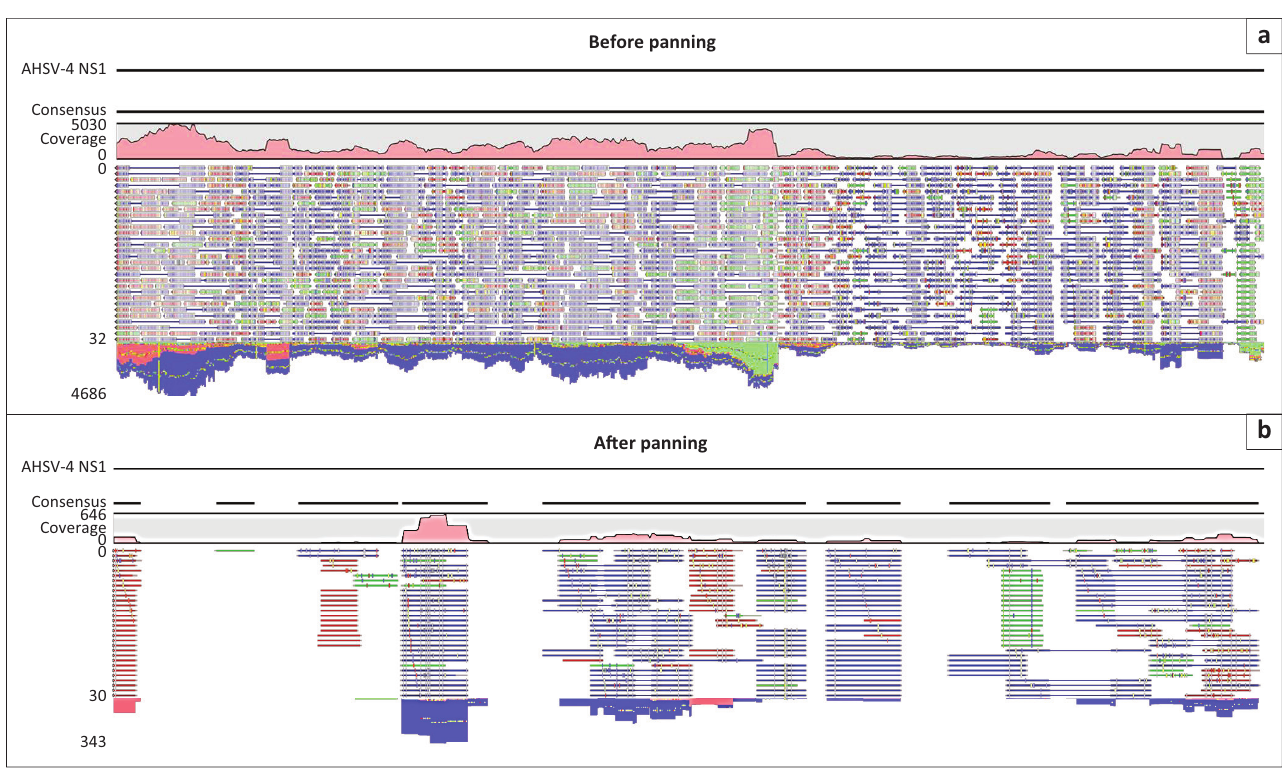
FIGURE 1-A1: An example of a CLC Genomics Workbench read mapping representation of sequenced inserts mapping to the African horse sickness virus-4 open reading frames segment encoding NS1. The sequences from the unpanned library (a) cover the entire gene without any gaps. The sequences from round three phages selected with day 28 IgG (b) has gaps, indicating that only regions of interest have been